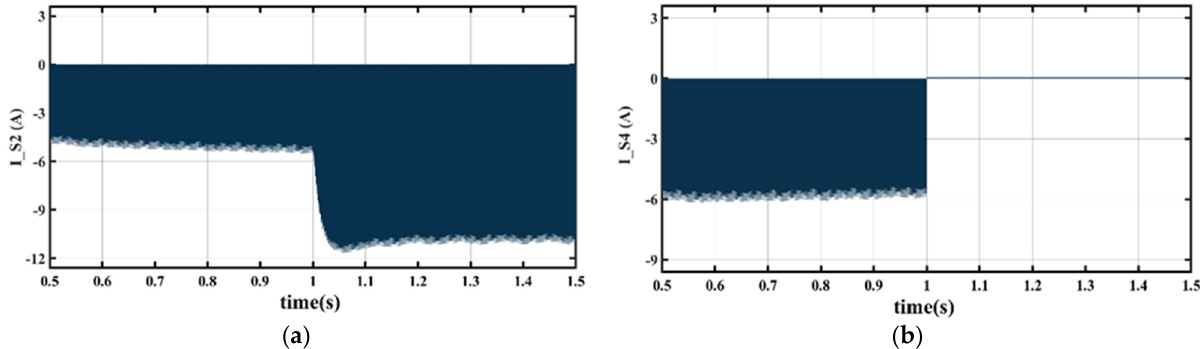
Figure 11. Simulation results during an OCF on power switch S4 in reverse mode: ( a ) current of switch S2 during an OCF on power switch S4 ; ( b ) current of switch S4 during an OCF.